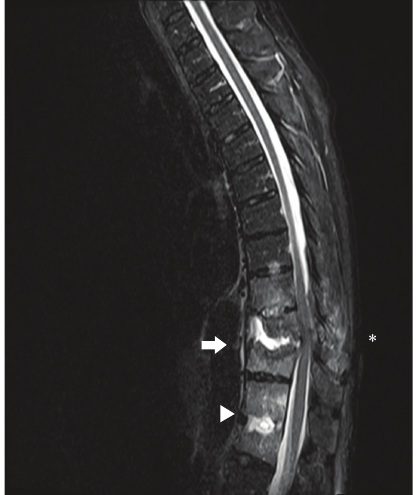
Figure 2: MRI of the thoracic and lumbar spine revealed spondy- lodiscitis in the thoracolumbar spine, worst at the T10-T11 level (white arrow) where there is associated paravertebral and epidural components with compression of the spinal cord. There is also oedema seen in the spinous processes of T9-T10 and the adjacent paravertebral muscles (Asterisk). Spondylodiscitis was also seen at T12/L1 level (white arrowhead).